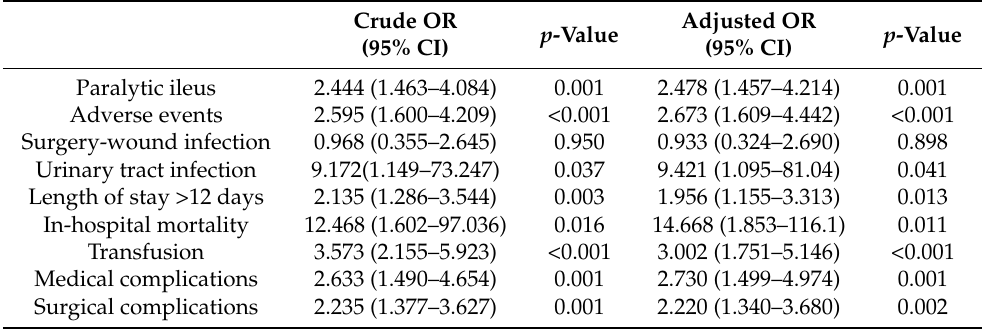
Table 4. Univariate analysis variables associated with nutritional impairment estimated by CONUT score at hospital discharge.